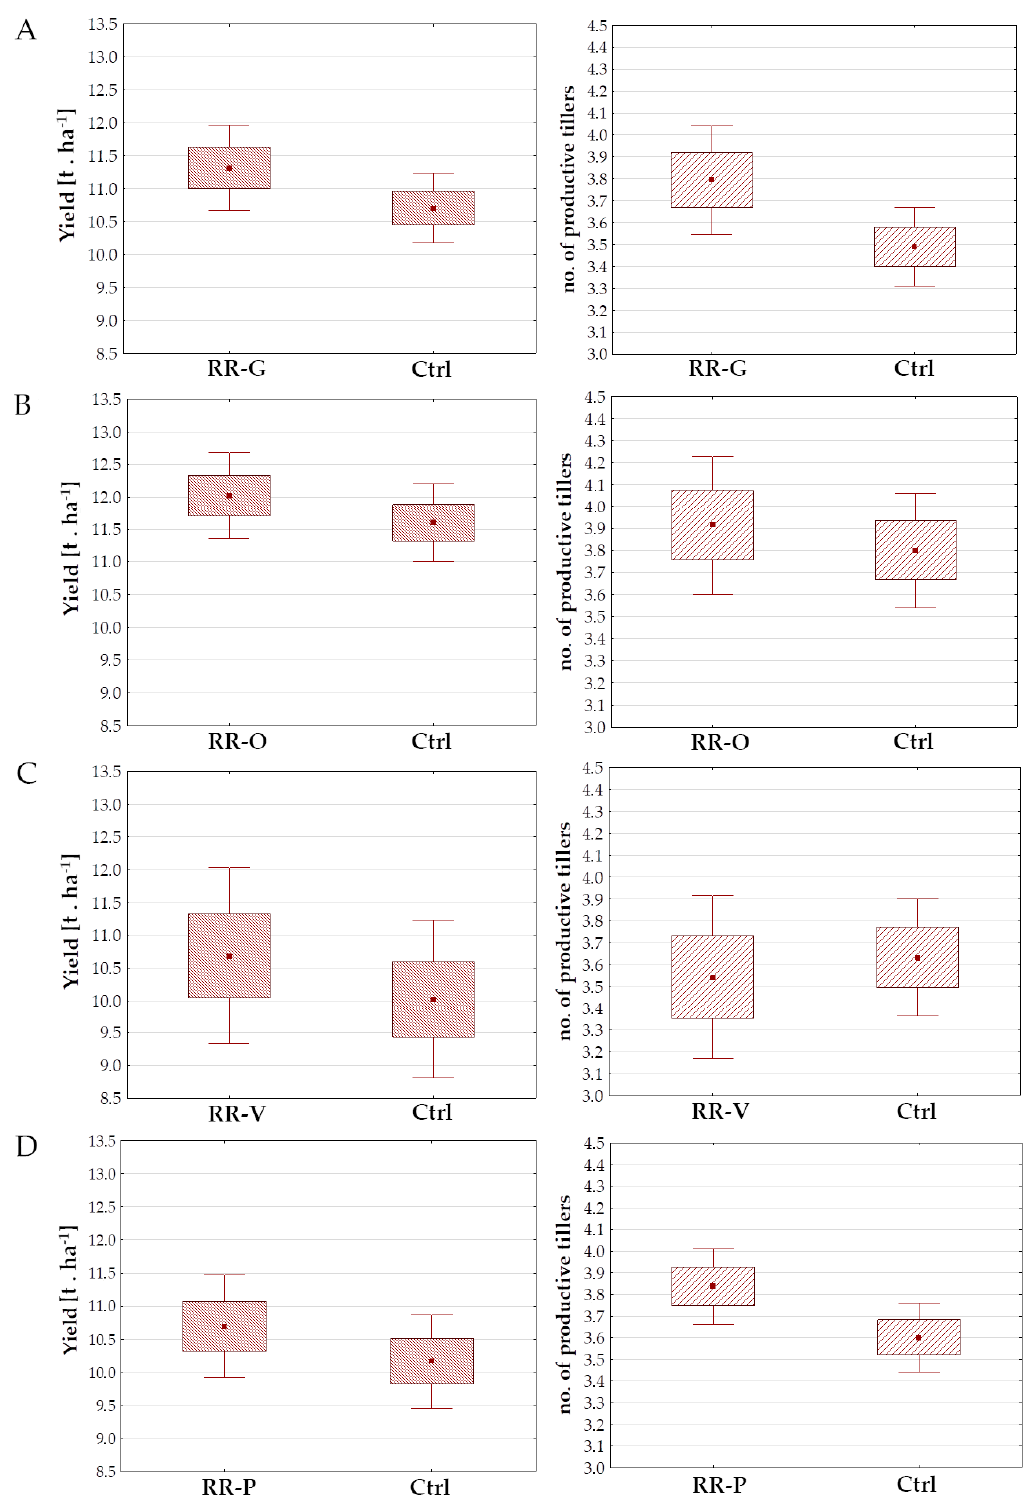
Figure 2. Results (grain yield in t · ha − 1 and number of productive tillers) from field plot experiments with winter wheat, compared to the control. ( A ) RR-P application as seed coating, ( B ) RR-G, ( C ) RR-O, and ( D ) RR-V applied as foliar spraying at the tillering stage (BBCH 21–25).